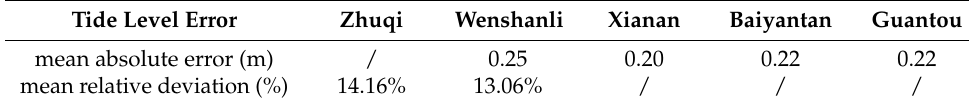
Table 1. Statistics of the tide level and flow simulation errors obtained for the 2016 data.